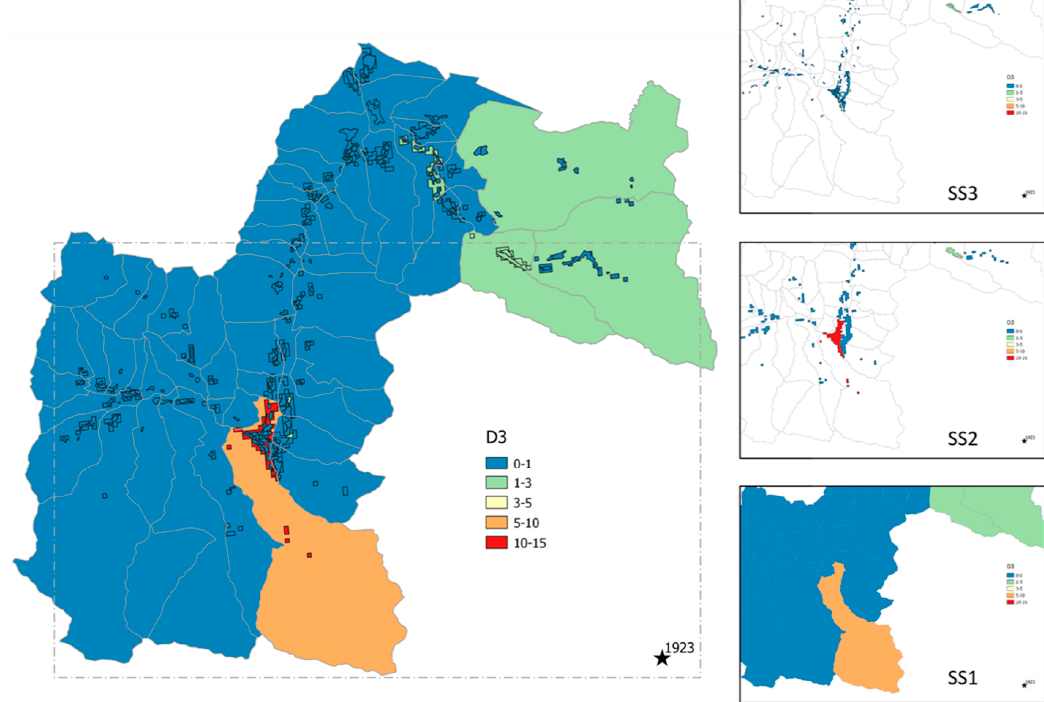
Figure 10. D3 damage distribution in the Luchon area in number of buildings at the 53 municipalities, due to the 1923 earthquake. The site effect is considered here.